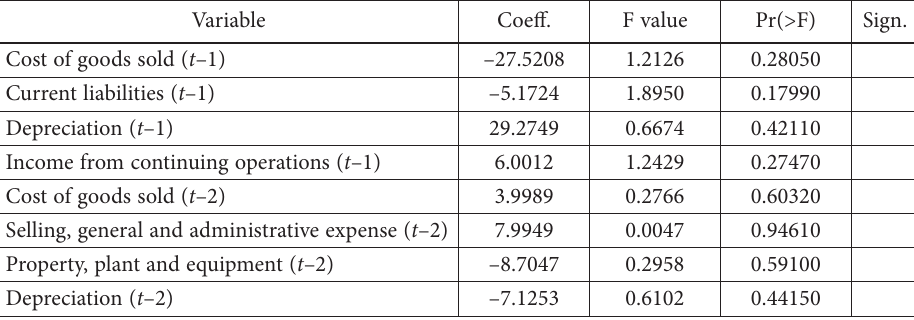
Table 7. Results of linear discriminant analysis for dataset